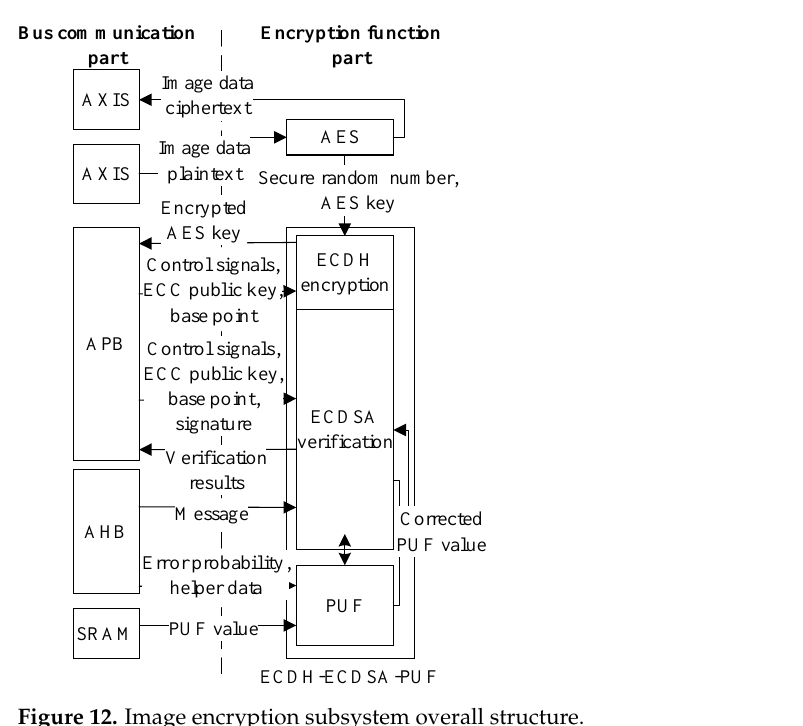
Figure 12. Image encryption subsystem overall